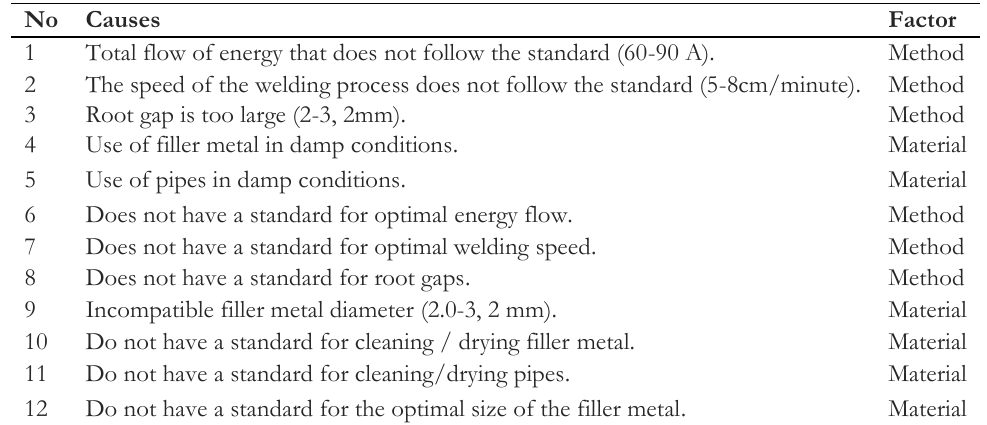
Table 3. Contributes to the causes of high energy consumption in the classification welding